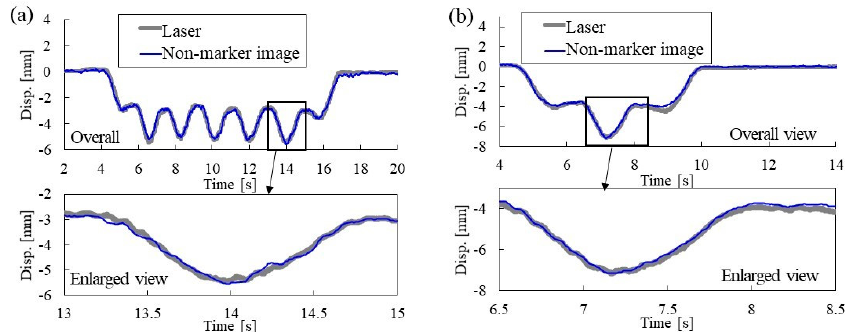
Figure 19. Comparison of displacement measurement results of bridge A during train passage: ( a ) six-car train and ( b ) two-car train.